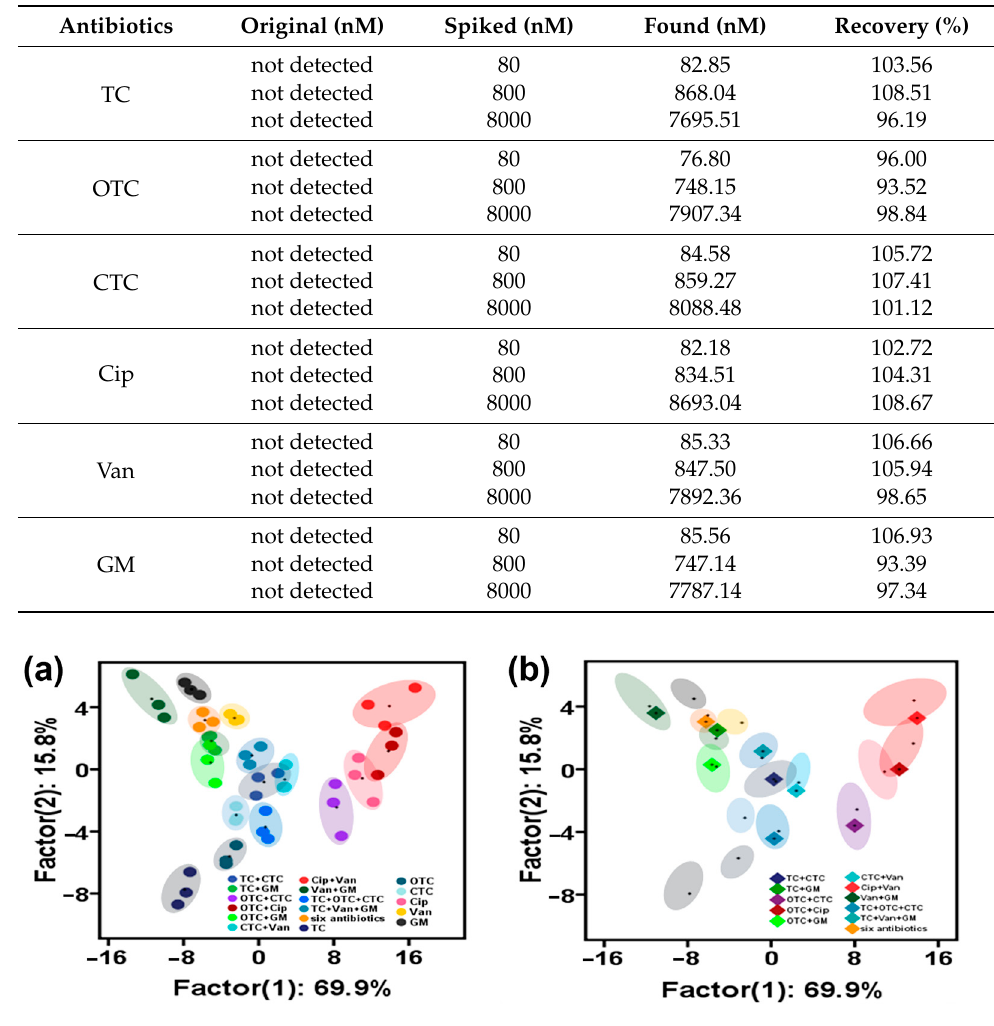
Table S2: Summary of the interaction between the antibiotic and metal ions reported in the literature; Table S3: LDA identification results of 6 antibiotics with different concentrations; Figure S4: